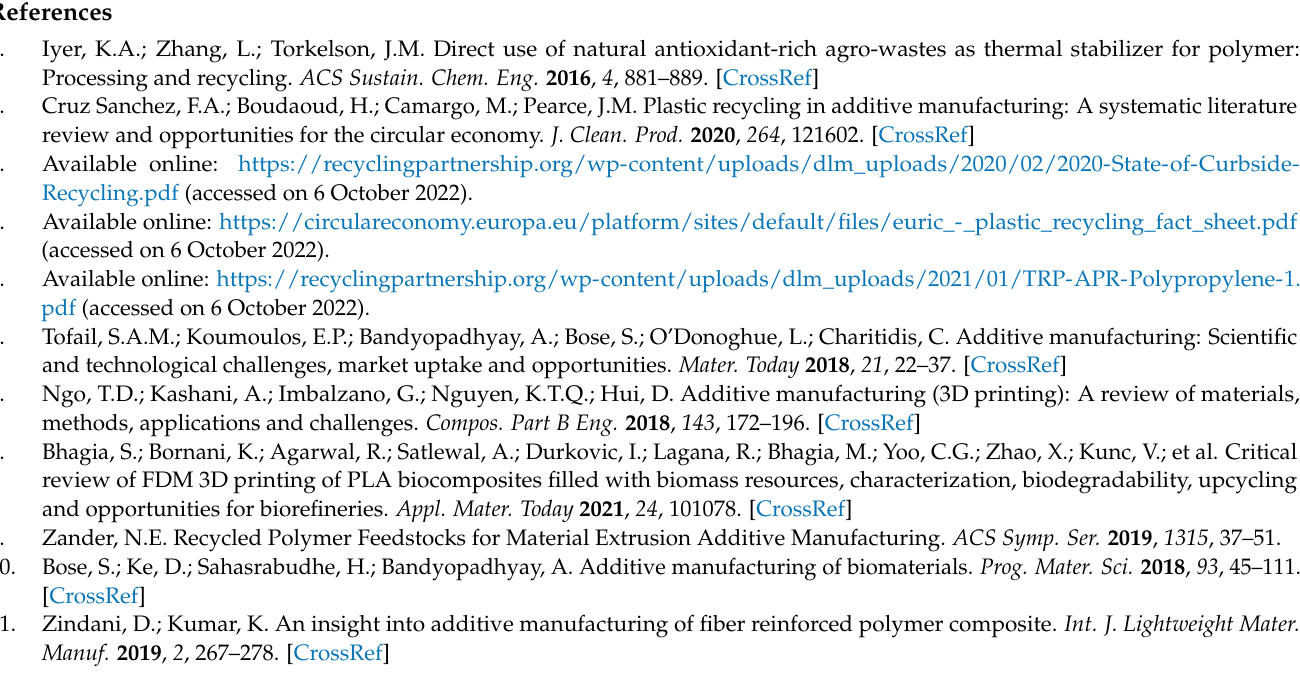
PPt; Figure S2. DSC thermograms recorded during the second heating scan for both r-PP and PPt; Figure S3. Screw profile selected for the material compounding and details of the screw elements. Table S1. TGA and DSC data of r-PP and